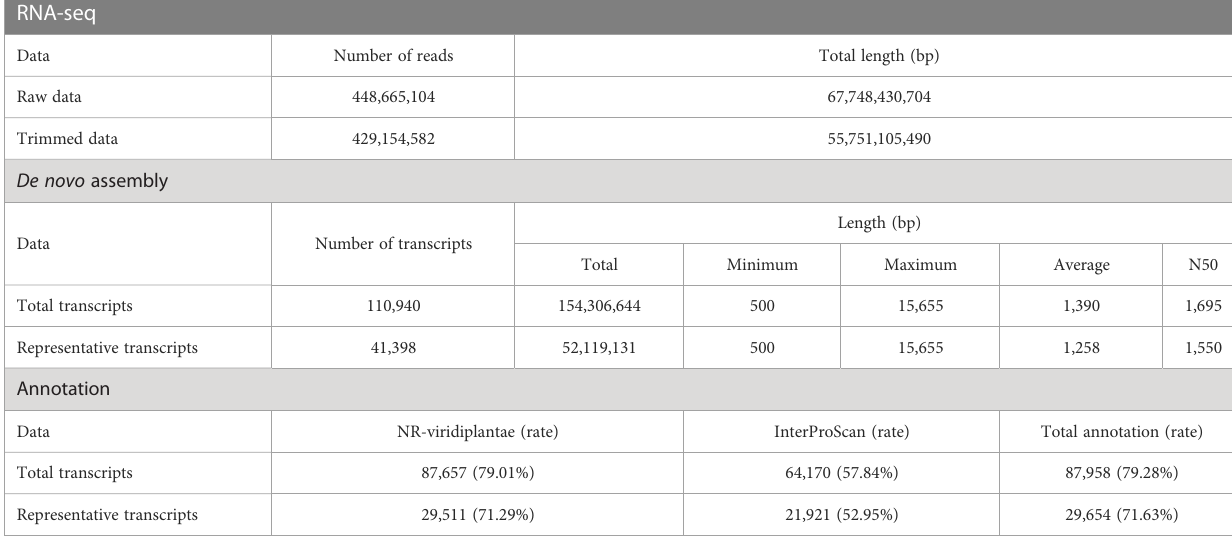
TABLE 1 Summary statistics of RNA-seq, de-novo assembly, and annotation. RNA-seq